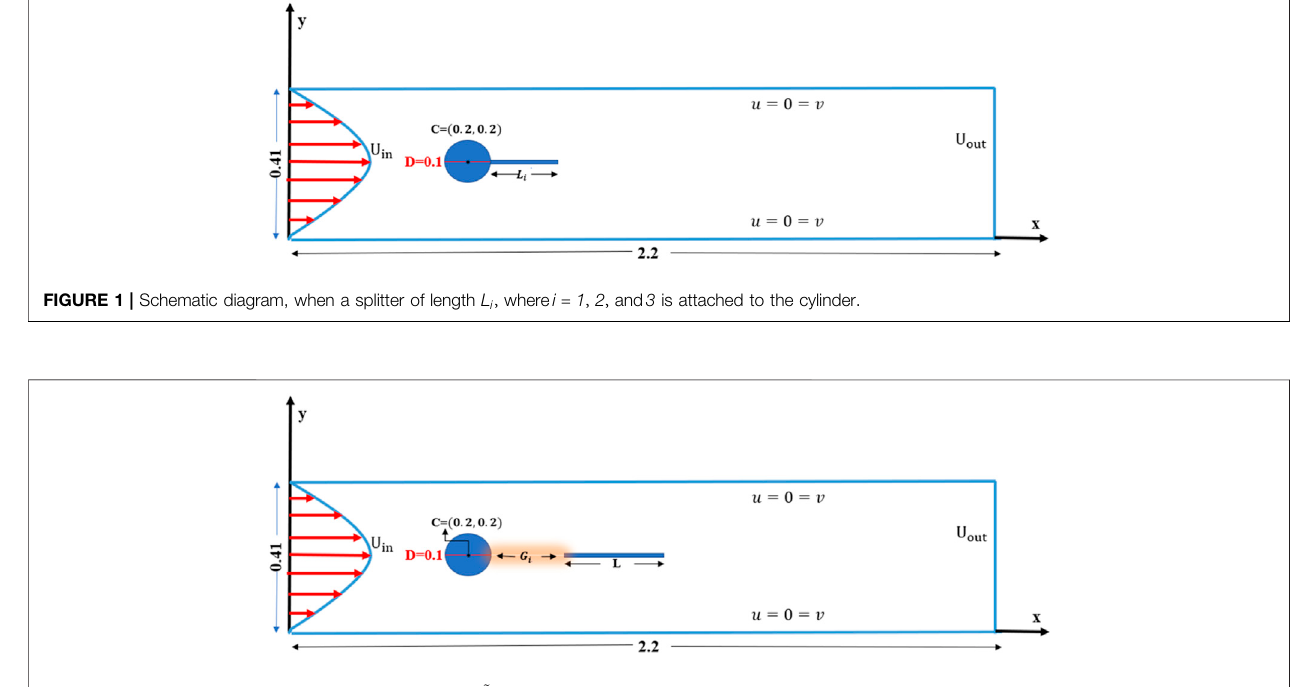
FIGURE 2 | Schematic diagram, when a splitter of length ~ L is fi tted at various gap separation G i , ( where i (cid:1) 1 , 2 , and 3 ) from the cylinder.